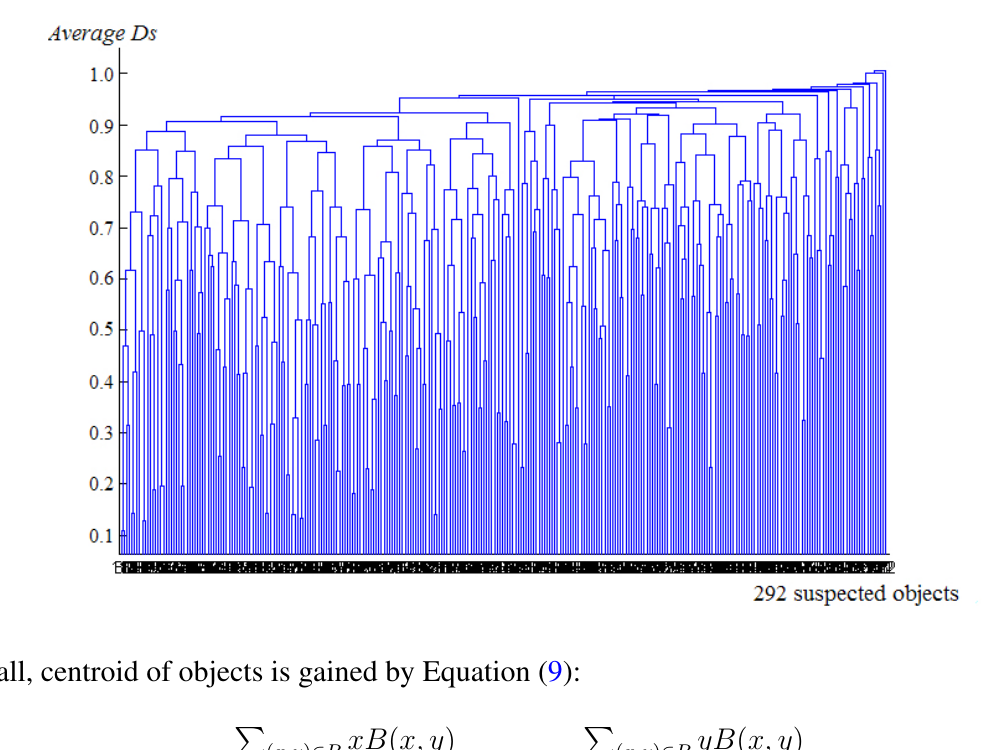
Figure 6. Dendrogram of one clustering on a sequence